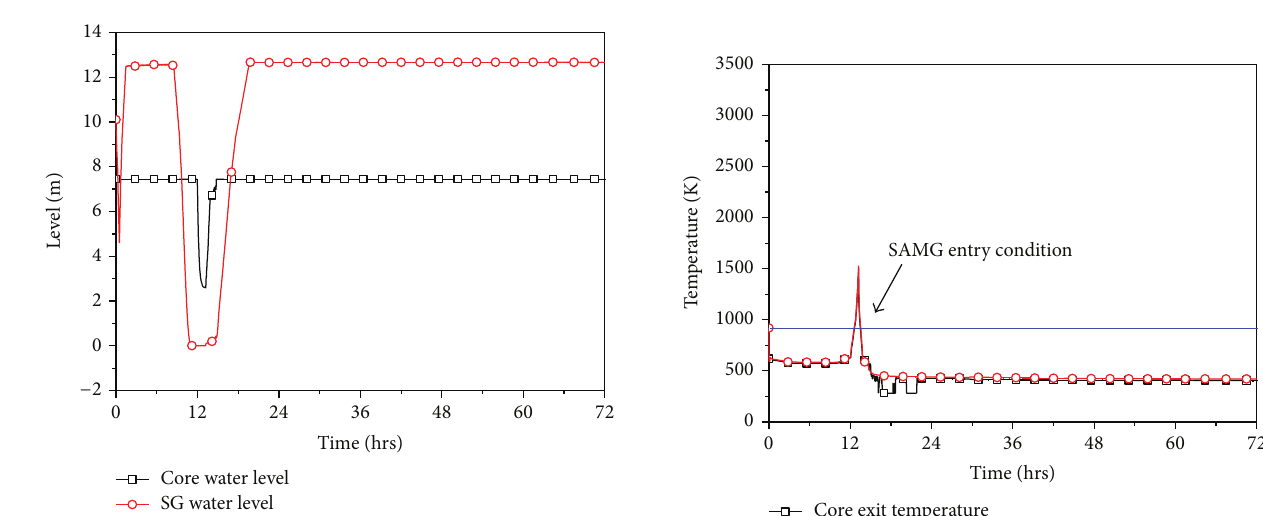
Figure 9: Secondary injection flow rate.